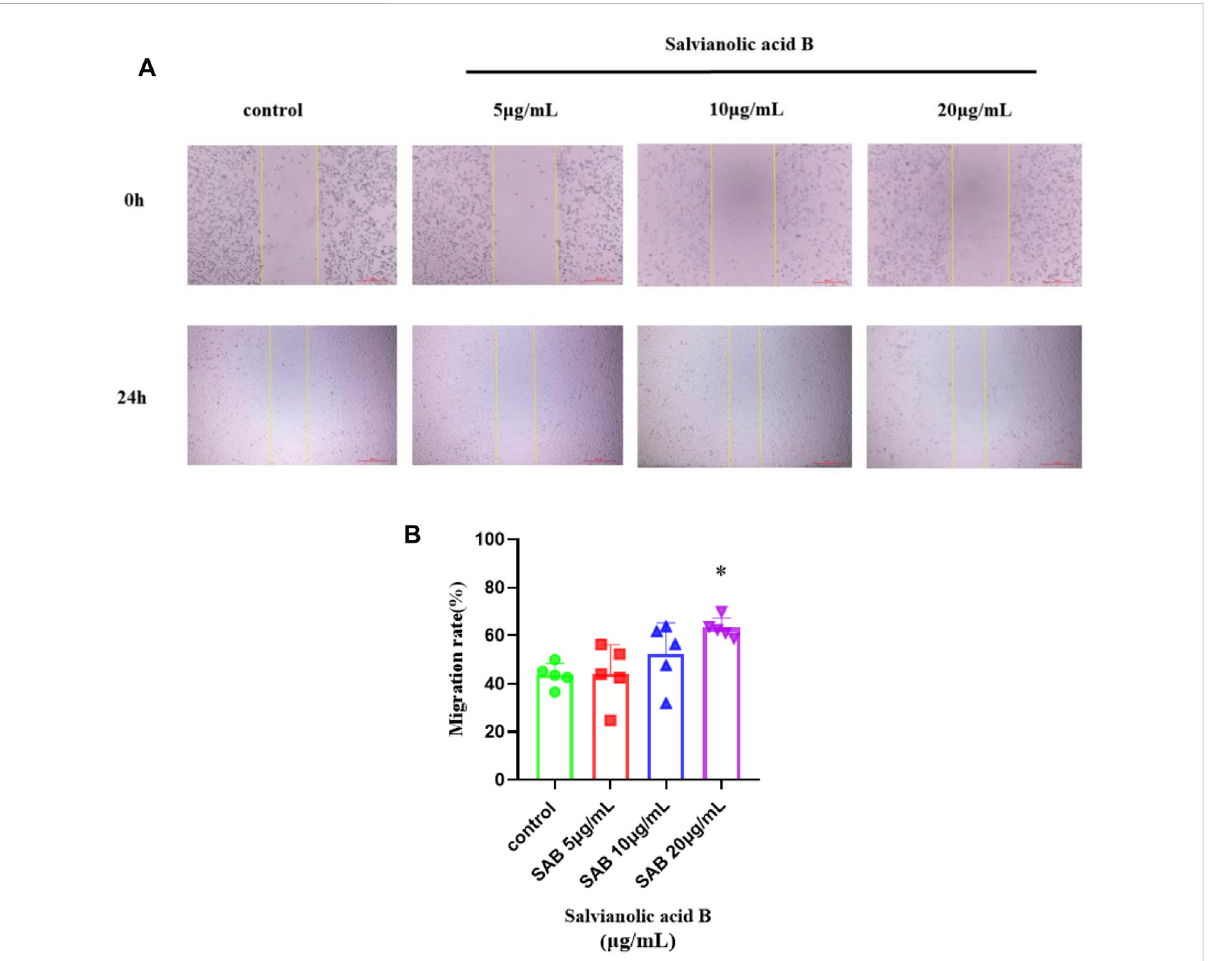
FIGURE 11 SalvianolicacidBpromotedthemigrationoflymphaticendothelialcells.TheimagerepresentsthechangesinthescratchwidthafterSalvianolic acidBtreatment. (A) .Theimagesofthescratches beforeLECsweretreatedandafterLECsweretreatedwiththreedosagesofSAB(5,10,and20 μ g/ ml) for 24 h. The distance between two yellow lines is the width of the scratch. (B) . Quantitation of migration rate. * p < 0.05 vs. Control